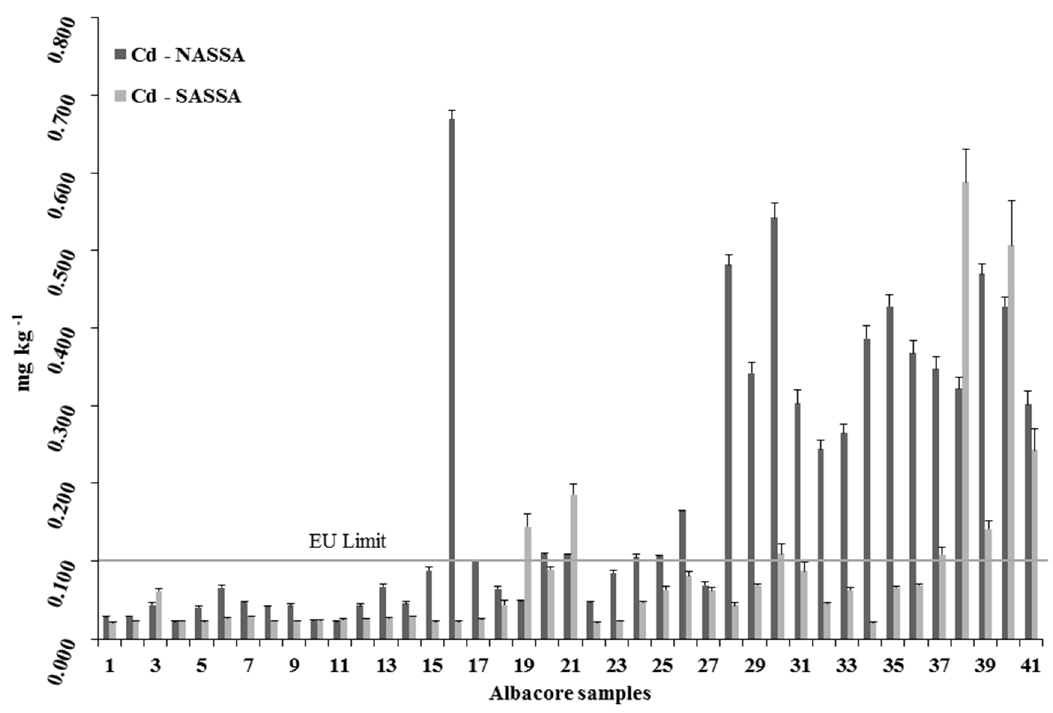
Figure 6. Cadmium concentrations in each individual T. alalunga , caught from NASSA and SASSA areas.